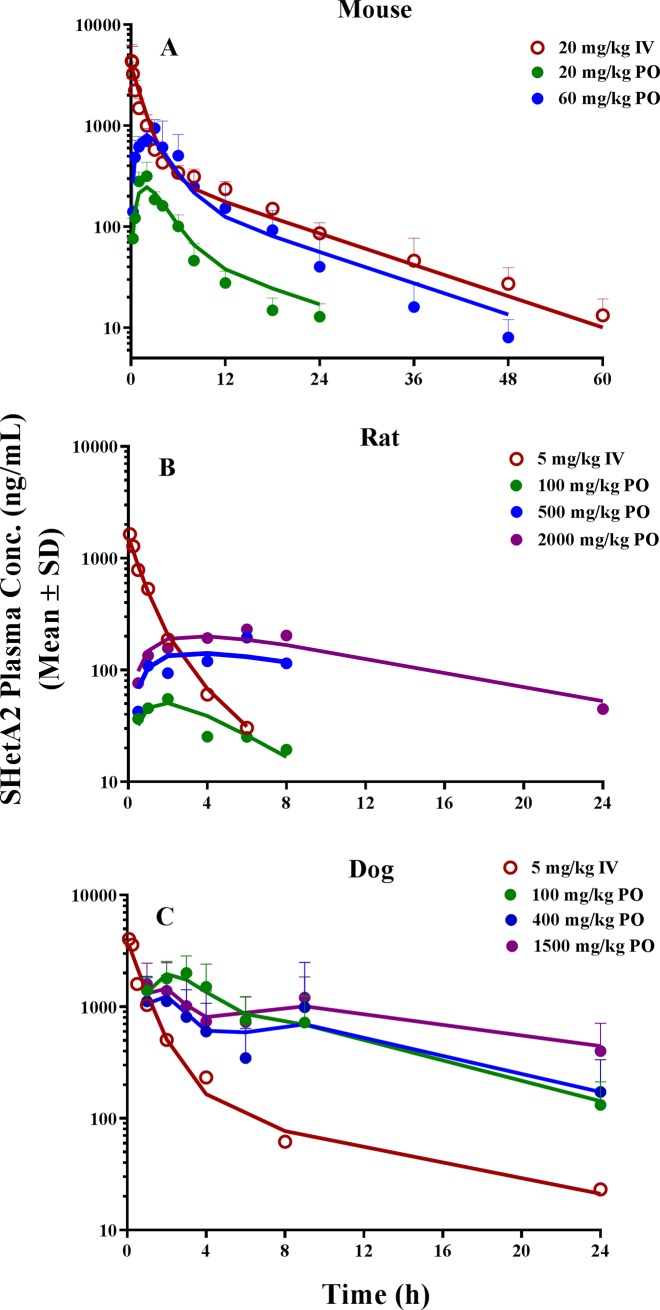
The plasma concentration-time profiles of SHetA2 following (A) 20 mg/kg IV dose and oral dose of 20 and 60 mg/kg in in mice (n = 3/dose), (B) 5 mg/kg IV dose and oral dose of 100, 500, and 2000 mg/kg in rats (n = 3/dose), and (C) 5 mg/kg IV dose (n = 2) and oral dose of 100, 400, and 1500 mg/kg (n = 4/dose) in dogs. Solid lines indicate the model-predicted values after simultaneous fitting of IV and oral PK data to the proposed PK models in each species. Symbols indicate the observed plasma concentrations (mean ± sd).